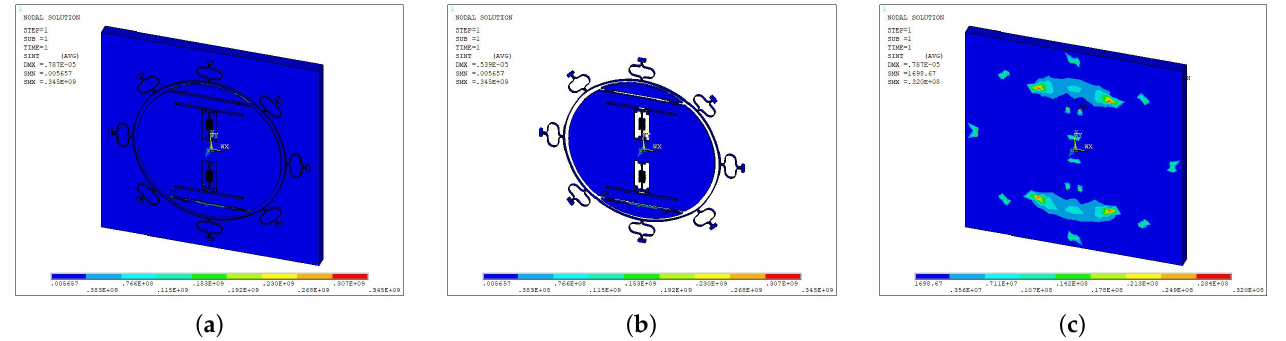
Figure 13. The deformation distribution of the single-chip integrated accelerometer gyroscope at 400 ◦ C. ( a ) The deformation distribution of the whole structure. ( b ) The deformation distribution of the silicon structure. ( c ) The deformation distribution of the substrate.